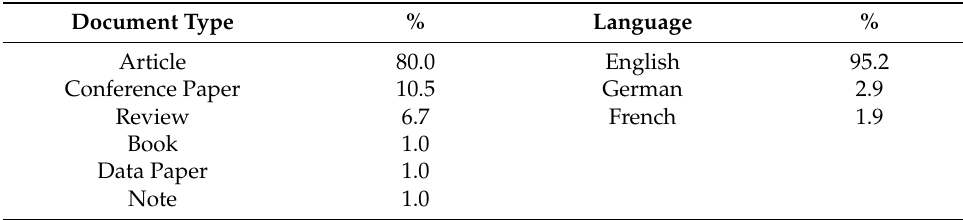
Table 2. Document type and language related to EEA research.